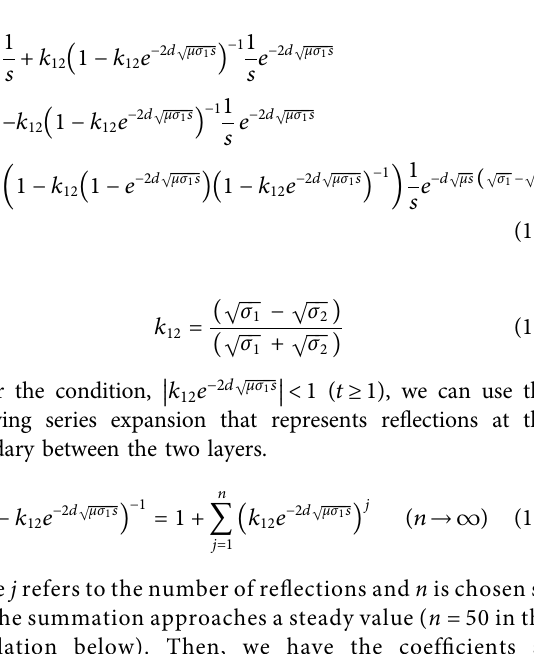
Memambetsu substation of Hokkaido Electric Power Co. Inc.